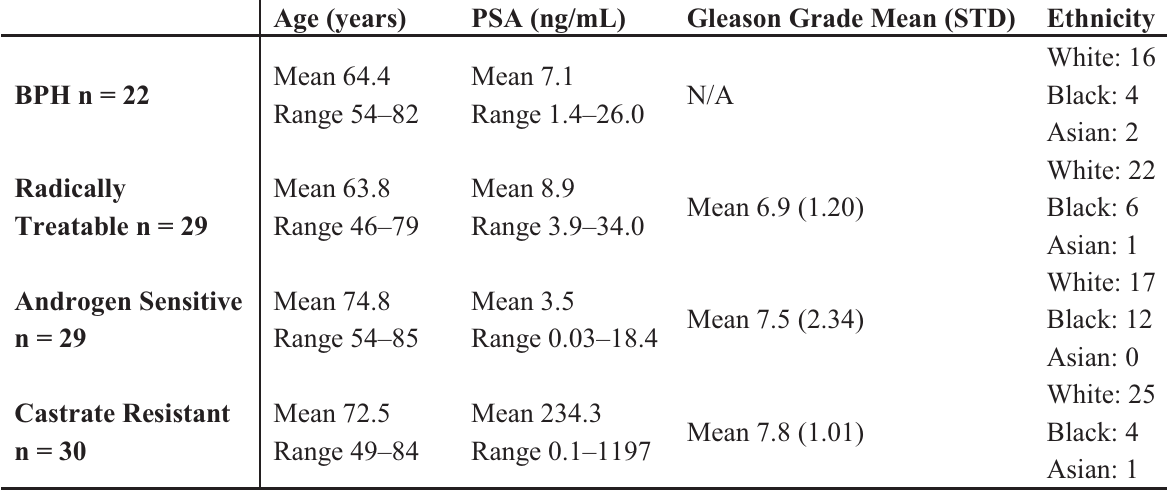
Table 1. Clinical and demographic characteristics of the study population.